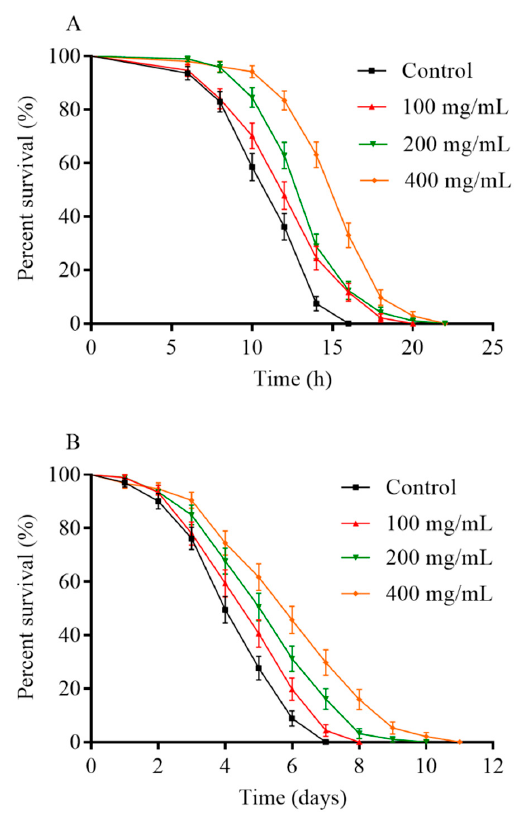
Figure 6. Effect of pretreatment with orange extracts on resistance to stress in N2 wild-type C. elegans . Nematodes were treated with various concentrations of orange extract (0, 100, 200, 400 mg/mL) as young adults for 5 days at 20 °C and then exposed to different stressors: ( A ) 35 °C thermal shock (N ≥ 95). ( B ) UV-B radiation at 120 mJ/cm 2 (N ≥ 92). The experiment was performed in triplicate. Table 2. Effect of orange extracts on heat shock of N2 wild-type C. elegans (mean ± SD, n = 3).